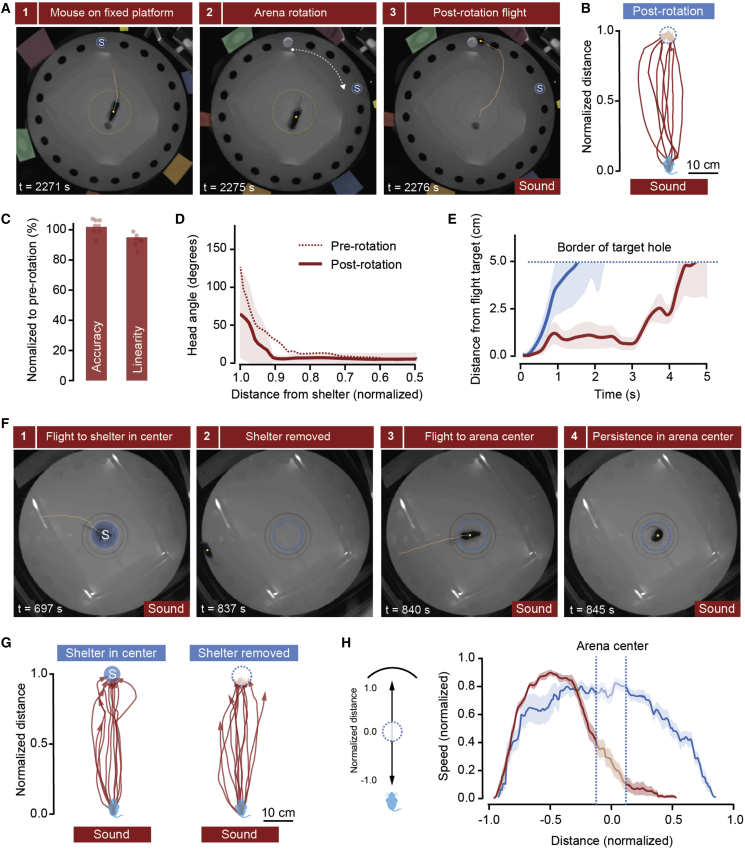
Memory of Shelter Location Guides Defensive Flight(A) Video frames from one trial showing escape from aversive sound immediately after the outside of the arena had been rotated, together with local cues (panels on the outside, color-coded for clarity). The dashed yellow line marks the diameter of the fixed platform, and the dashed blue circle shows shelter location before rotation.(B) Trajectories from different mice after arena rotation, showing escape toward the previous shelter location (dashed blue circle).(C) Escape behavior is not significantly changed by arena rotation (accuracy = 102% ± 1%, linearity = 96% ± 2% of control). Reaction time is also not affected (93% ± 14%). p > 0.1 for all comparisons, paired t test between pre- and post-rotation; n = 8 animals.(D) Head rotation profile during escape initiation is not affected by arena rotation (p = 0.39, paired t test between pre- and post-rotation for distance at 10°). Post-rotation angles are measured between the mouse position and the shelter position before rotation. The shaded area indicates the SD.(E) Plot showing when the mouse leaves the initial target hole area after the flight. Red indicates flights after rotation, and blue indicates flights in control conditions where the shelter target was missed. The shaded area indicates the SEM.(F) Video frames from one trial showing sound-evoked flight to a shelter in the center of the arena and persistence of escape to the arena center after the shelter has been removed.(G) Escape trajectories for different mice before (left) and after (right) a shelter in the arena center was removed.(H) Speed profile for escape responses when the shelter is in the periphery (blue; from the same dataset shown in Figure 1) and after the shelter has been removed from the arena center.See also Figure S2 and Movie S2.